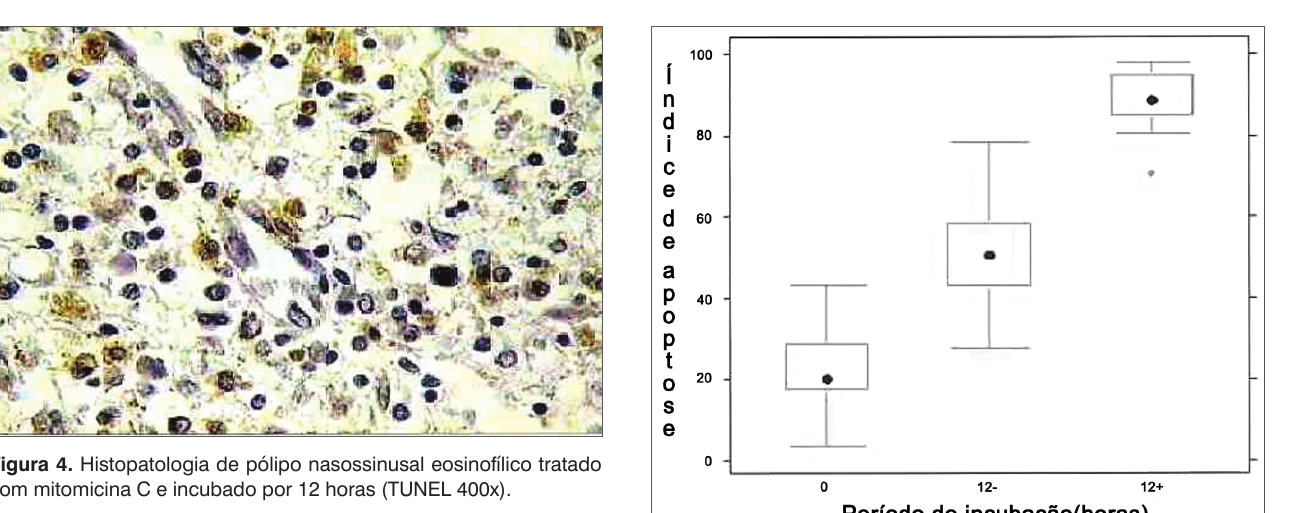
Sabe-se que eles prolongam a sobrevida do infiltrado inflamatório em pacientes com polipose nasossinusal eo- sinofílica 28 . A remoção dos eosinófilos do tecido polipóide ocorre por meio da apoptose 29 . O número de células